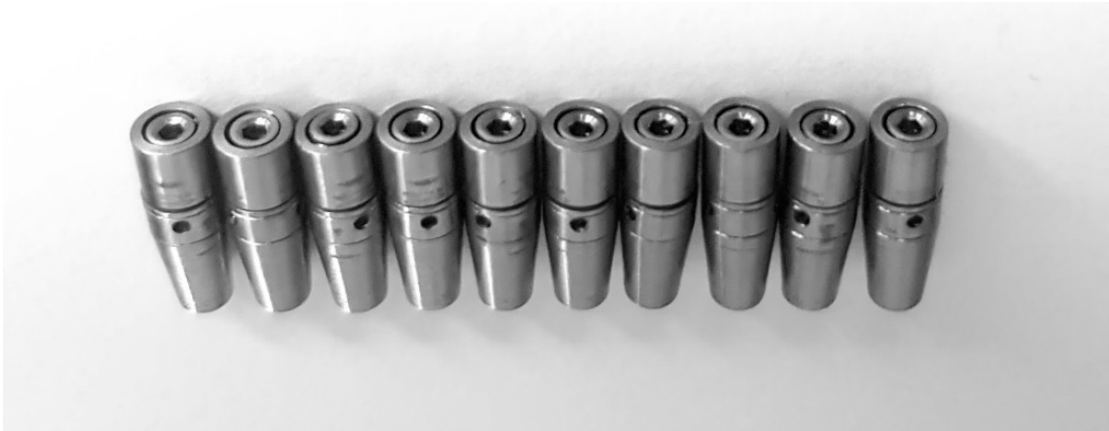
Figure 5. The entire batch of implants before testing. Implants numbered 1 to 10 from left to right.